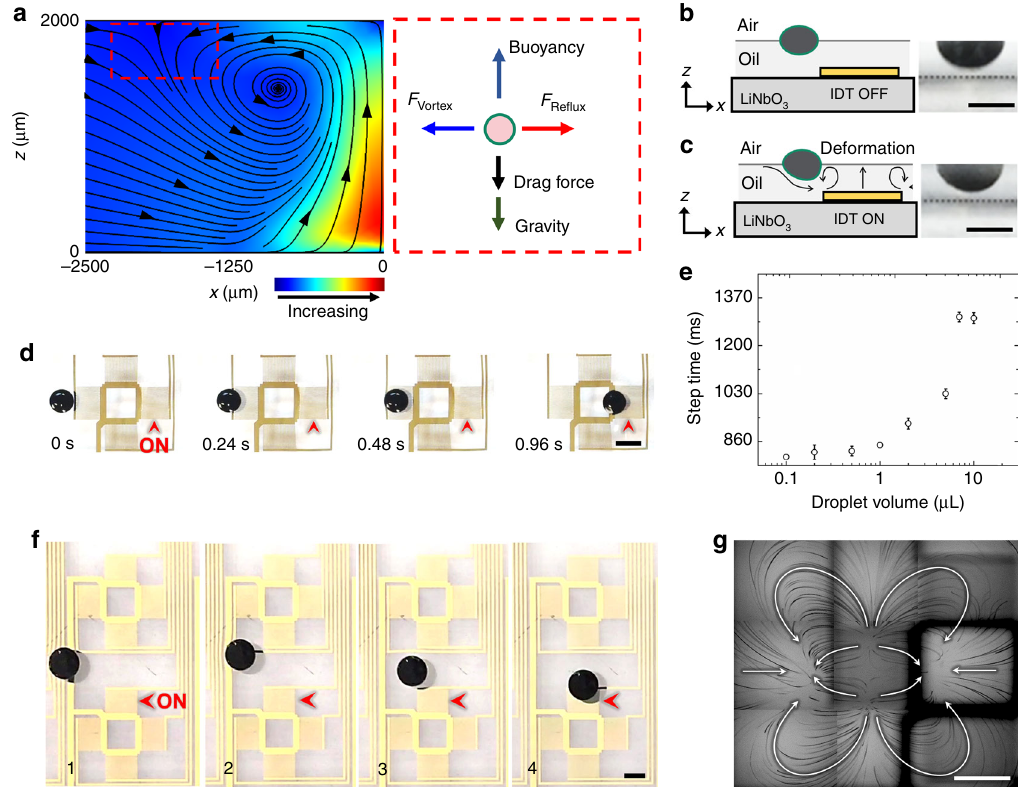
Fig. 3 Characterization of the hydrodynamic trap. a Calculated streamlines from a numerical model of the forces generated by acoustic waves in the x – z - plane, and an illustration of the force balance along the x – z- plane at the trap. The counter-rotating vortices are clearly seen. Re fl ux and counter-rotating vortices cancel each other out and stabilized the droplet in the ± x directions. The drag force represents the sum of z -components of drag forces from counter-rotating vortex and re fl ux. b Side view of the immersed part of a 5 µ L droplet when the IDT is turned off. The gray dashed line indicates the plane of the LiNbO 3 substrate. c Side view of the immersed part of a 5 µ L droplet when the IDT is turned on. The droplet slightly deforms upon the activation of acoustic streaming but remains fl oating on the oil layer, and above the substrate. d A sequence of time-elapsed, top-view images of the droplet-trapping process. The red arrow indicates the activated IDT. Two symmetrical hydrodynamic traps are created on opposite sides of the transducer, and the nearby droplet is transported by following the hydrodynamic gradient. Note that at 960 ms, the trapped droplet is mildly pinched and deformed by the counter- rotating vortices near the two transducer apertures. The 5 µ L droplet ’ s shape conforms with the streamline distribution in Fig. 2f. e The relationship between the droplet volume and the step time. ‘ Step time ’ represents the time needed for translating 6.5 mm and stopping a droplet, the distance of a single step. f A free- fl oating droplet is restabilized near an excited IDT. The droplet naturally follows the local pressure gradient towards the IDT and then is stabilized at one of its hydrodynamic traps. g Particle tracking result showing the streaming pattern on the oil ’ s surface (top view). All streamlines of the re fl ux and the counter-rotating vortices converged at the two hydrodynamic traps. For a more detailed description of this image, please see